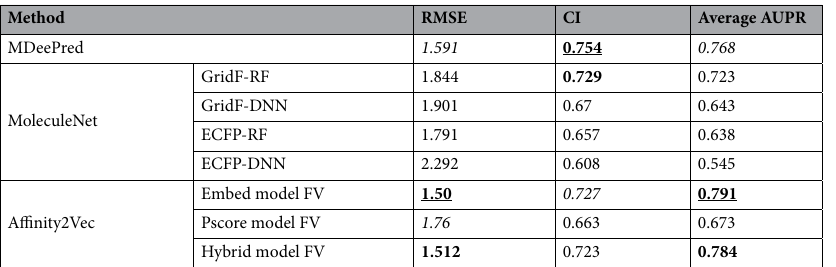
Table 7. Performance results of Affinity2Vec, MDeePred, and the MoleculeNet benchmarking methods (under setting-2) based on the PDBBind refined dataset. Bold font with underline (indicate the best results), bold font (indicate the second-best results), and italics (indicate the third-best results).